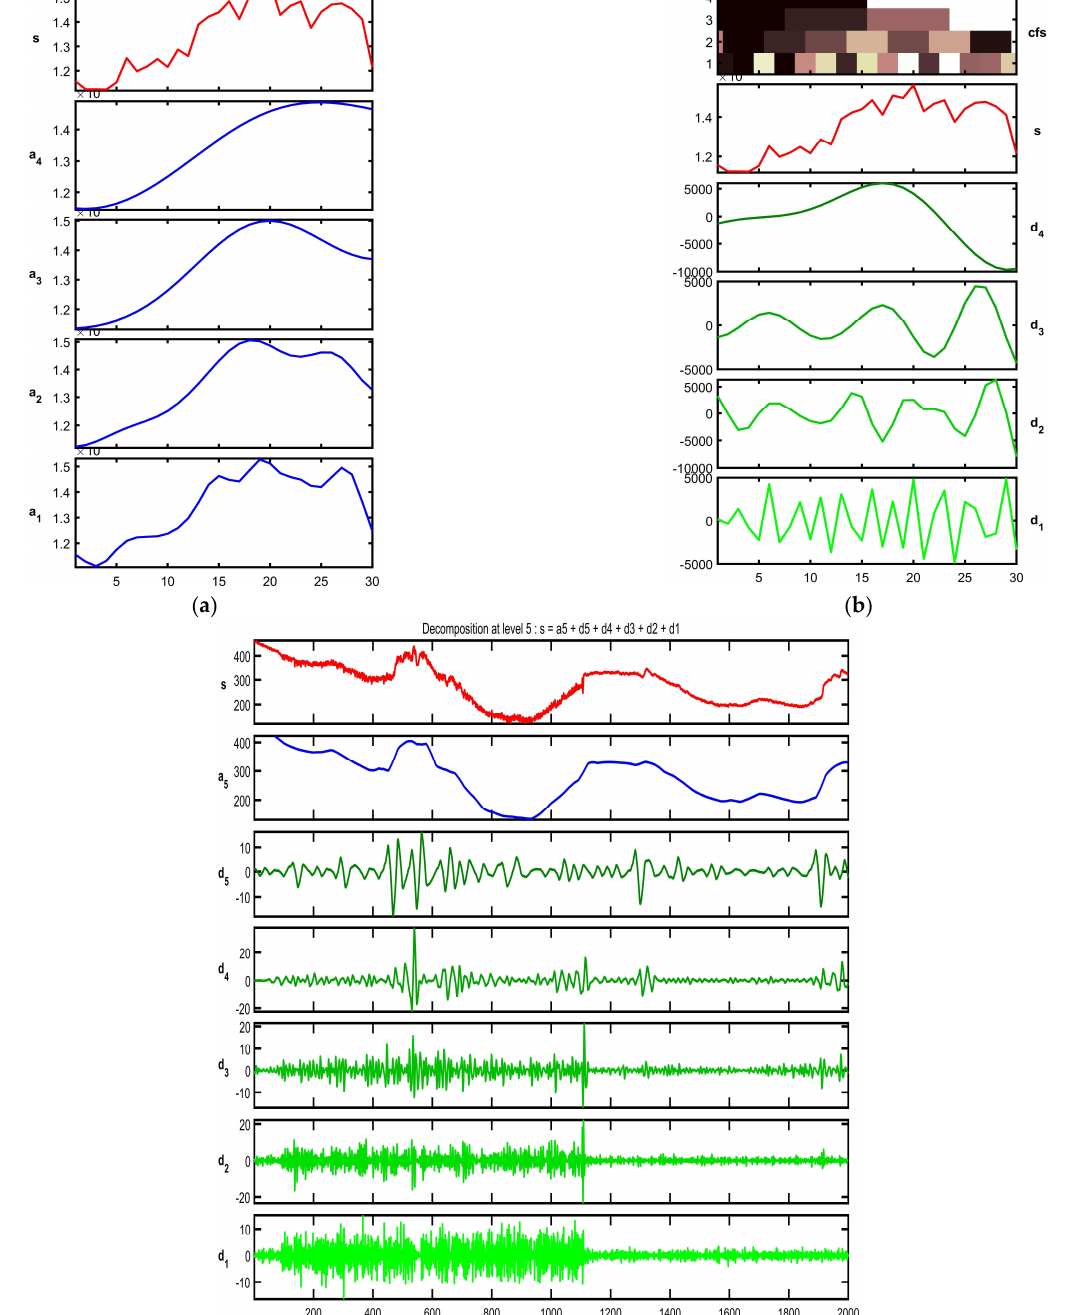
Figure 5. Wavelet approximation of a series representing energy consumption in EU service en- terprises: ( a ) the course of wavelet coefficients of the approximation component and ( b ) course of wavelet coefficients of detailed components, ( c ) wavelet decomposition of a discrete Meyer wavelet fundamental signal for energy consumption (basic signal electrical consumption). Source: Own elaboration based on MATLAB & Simulink